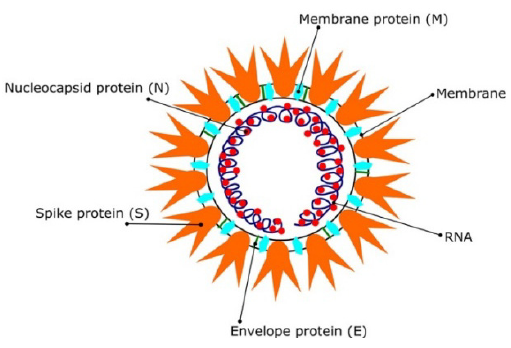
Figure 1. The SARS CoV2 virions structure. Schematic representation reproduced with permission from reference [12]. Copyright © 2021 Informa UK Limited, trading as Taylor & Francis Group.